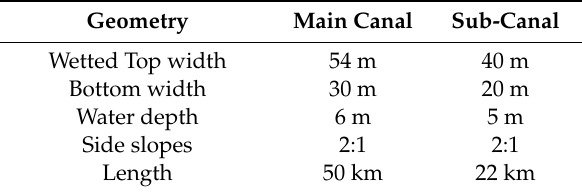
Figure 1. Location of Toshka, Sheikh Zayed canal, its branches, and pumping station. Table 1. Dimensions of Sheikh Zayed main and sub-canal.